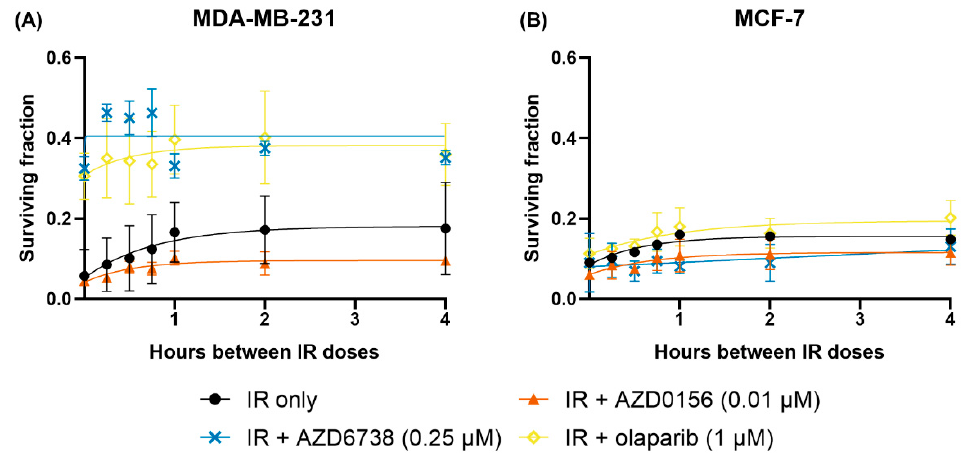
Figure 8. AZD6738 attenuates SLD repair in MDA-MB-231 cells. ( A ) MDA-MB-231 and ( B ) MCF-7 cells were treated with AZD0156 (0.01 µ M), AZD6738 (0.25 µ M) or olaparib (1 µ M) one hour prior to irradiation with two 1.5 Gy doses separated by 0 to 4 h, except for MDA-MB-231 cells treated with AZD0156 in which two 1 Gy doses were used. Cell survival was then quantified with clonogenic assays, and the surviving fractions were fitted to graphs using the one-phase exponential model. The survival curves of cells treated with two 3 Gy IR doses were only displayed for comparison. Data are shown as mean ± SD of three independent experiments performed in duplicate wells. Table 3. SLD repair half-time ( t 1⁄2 ) in minutes and ratio of the surviving fraction after 4-h fractionated IR to non-fractionated IR (SF 4h :SF 0h ) of MDA-MB-231 and MCF-7 cells treated with IR only and in combination with AZD0156 (0.01 µ M), AZD6738 (0.25 µ M) or olaparib (1 µ M). In the AZD0156 treatment group, MDA-MB-231 cells were irradiated with two 1 Gy doses, while MCF-7 cells were irradiated with two 1.5 Gy doses. t 1⁄2 values were estimated from the survival curves in Figure 8, and values for the two 1.5 Gy IR + AZD6738 (0.25 µ M) groups were unavailable due to ambiguous or interrupted fits with the one-phase exponential model. Data were obtained from three independent experiments performed in duplicate or triplicate